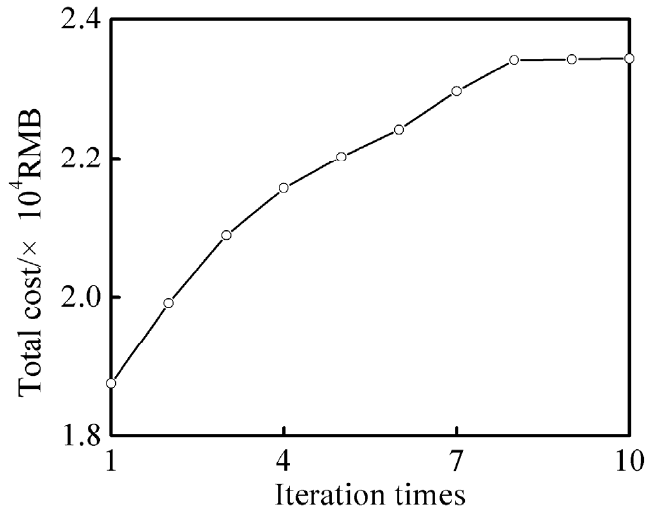
Figure 6. Iterative convergence of the robust optimization model under Scenario 4.